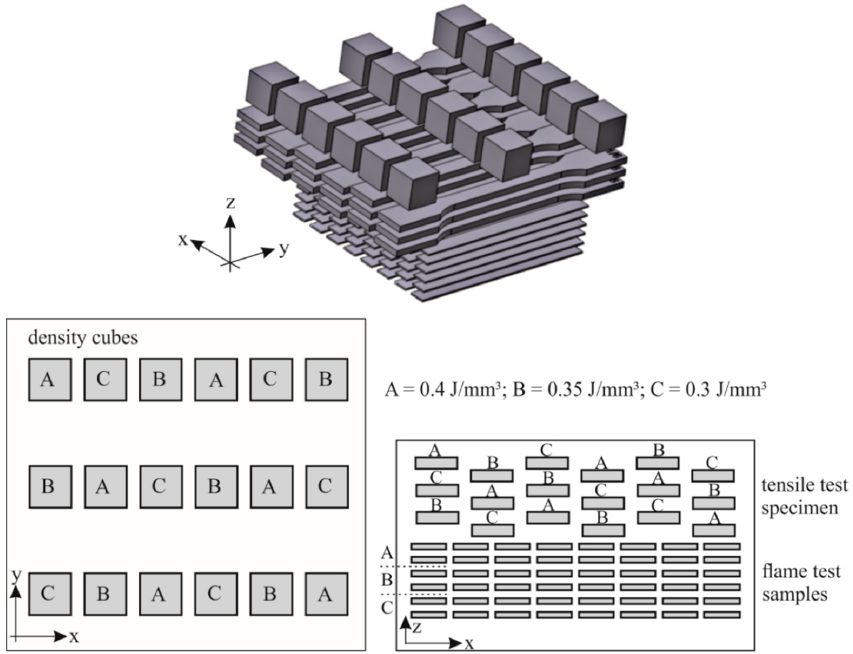
Figure 1. Building process layout and classification of the energy density of the cubes for density Figure measurements.